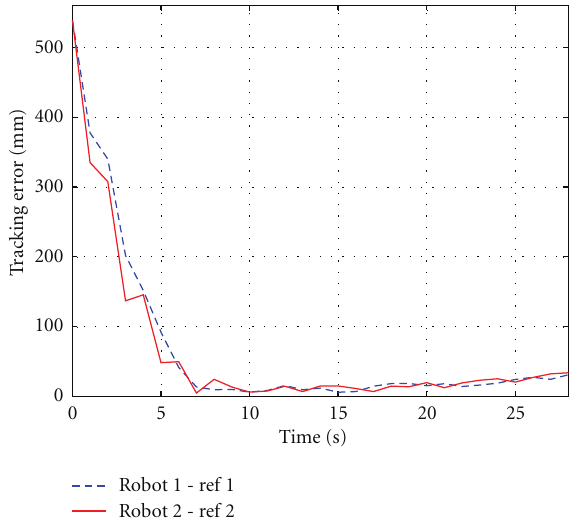
Figure 13: Group movement tracking curve. Figure 14: Consensus tracking errors for the virtual position: curvilinear